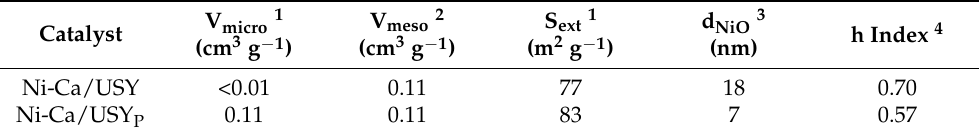
Table 3. Main properties obtained for the Ni-Ca/USY and Ni-Ca/USY P catalysts after calcination. Catalyst